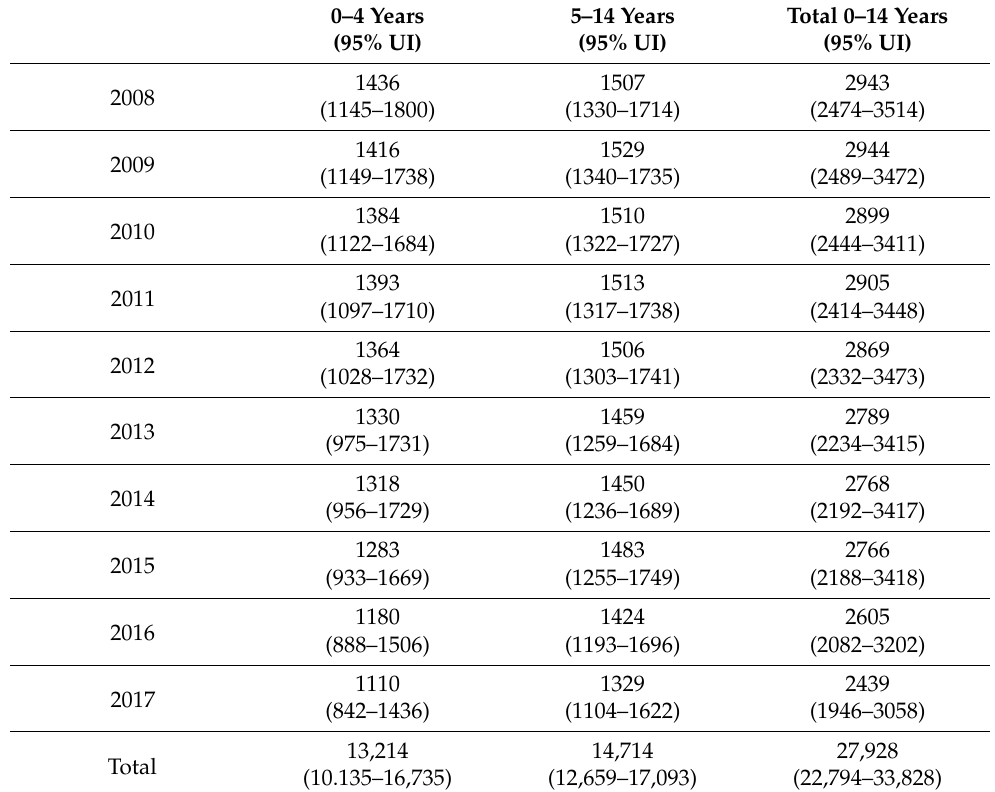
Table 1. Number of drowning deaths by year and age group, children 0–14 years, Philippines,